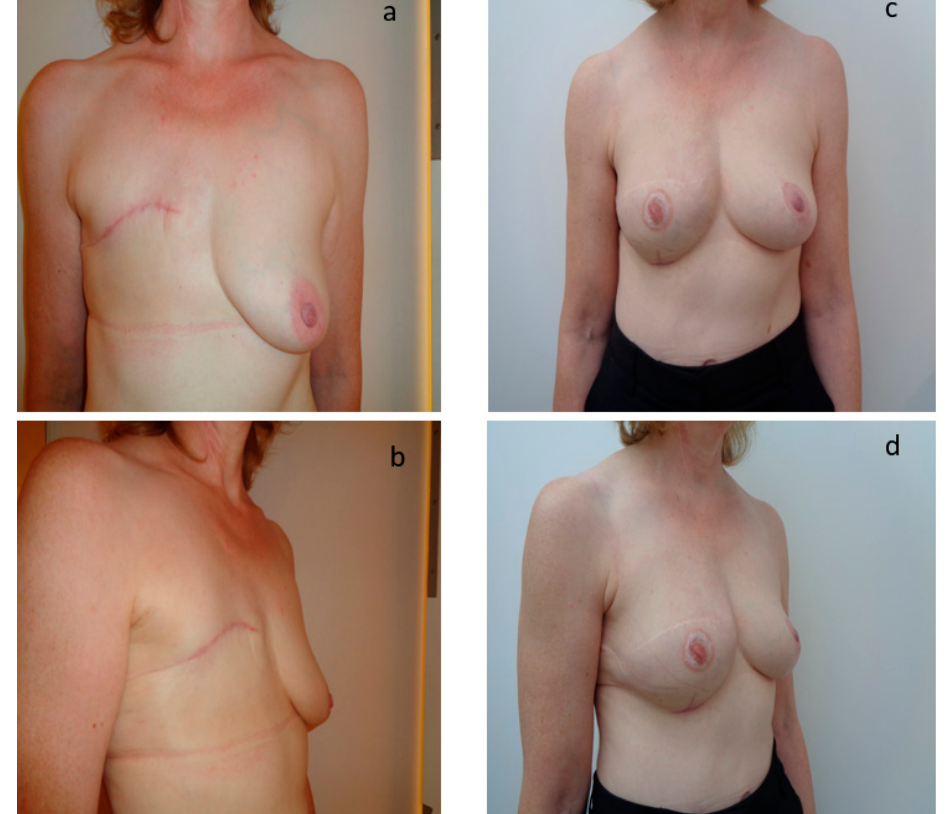
Figure 3. Aesthetic result after breast reconstruction by exclusive lipofilling in patient with C bra size. ( a , c ) Results after total mastectomy; ( b , d ) Results after 3 sessions of reconstruction by exclusive lipofilling. The scar in the sub mammary fold was a small pexia to reshape the breast and make it more symmetrical to the other breast, which had been lifted with an inverted ‐ T reduction surgery.